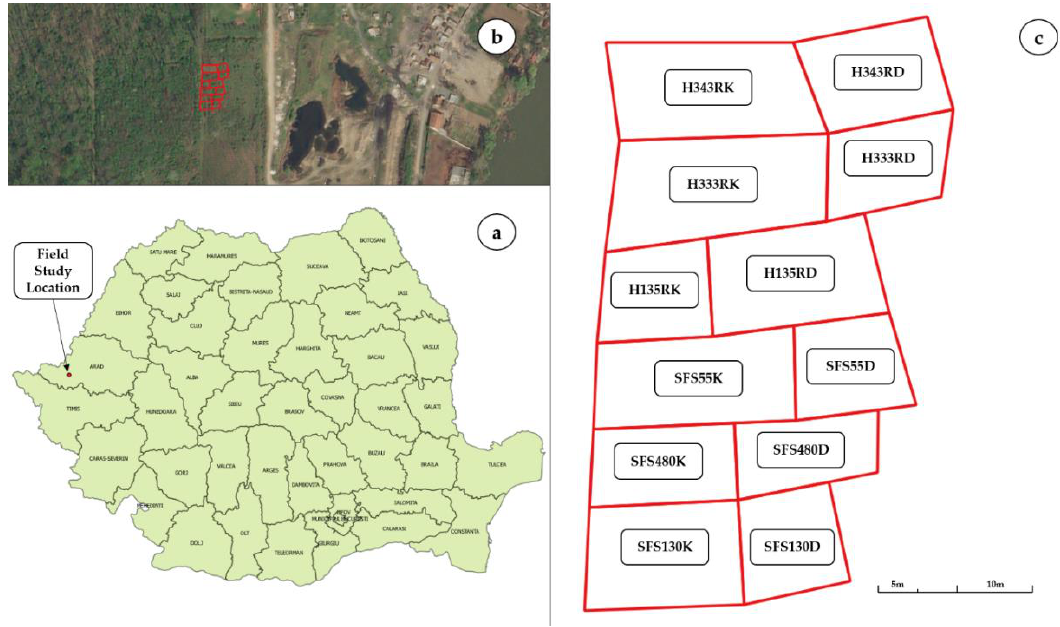
Figure 1. Location of the field tests. Legend: ( a )—Location of the study at the national level; ( b )—location of the plots in the forest taken into study; ( c )—map of the plots showing the name of the treatments by their code, where H stands for Husqvarna, S stands for Stihl, D stands for disc, and K stands for knife, as the active cutting devices, while the rest of each code indicates the tool model.